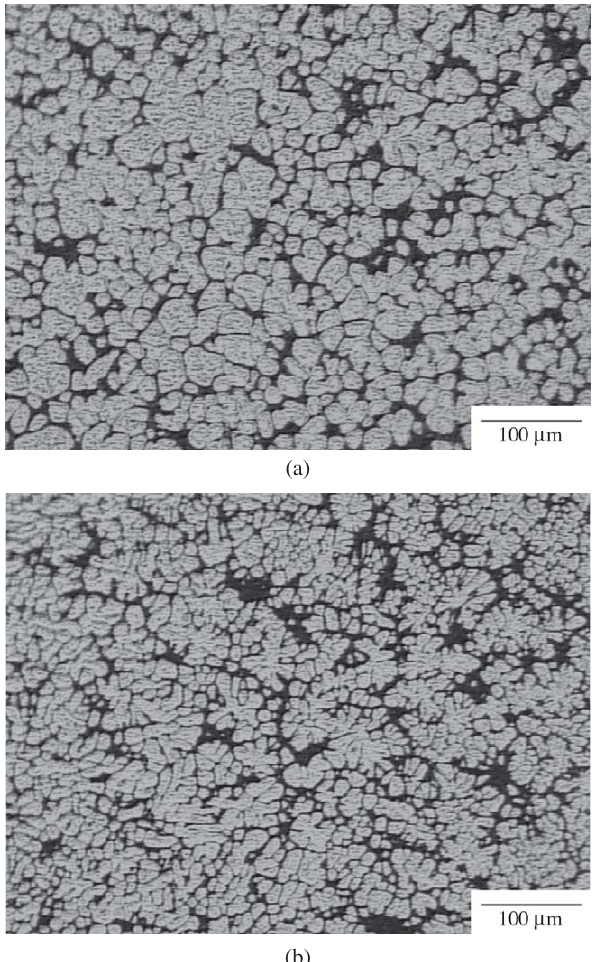
Figure 5. Microstructures of the A356 MHD-conditioned billets in the as-cast condition: a) ingot centre; b) ingot